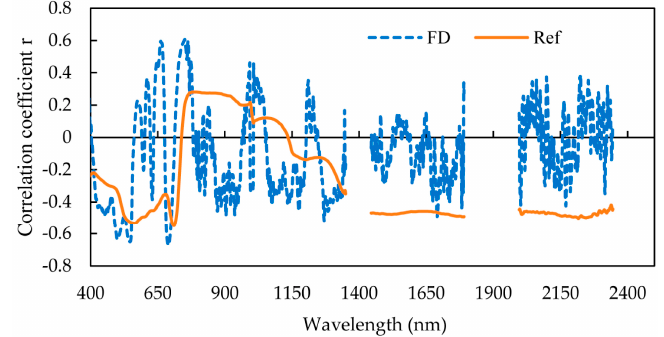
Figure 3. Correlation between model set reflectance spectra (Ref) and first derivative spectra (FD) and LNC of the training set.